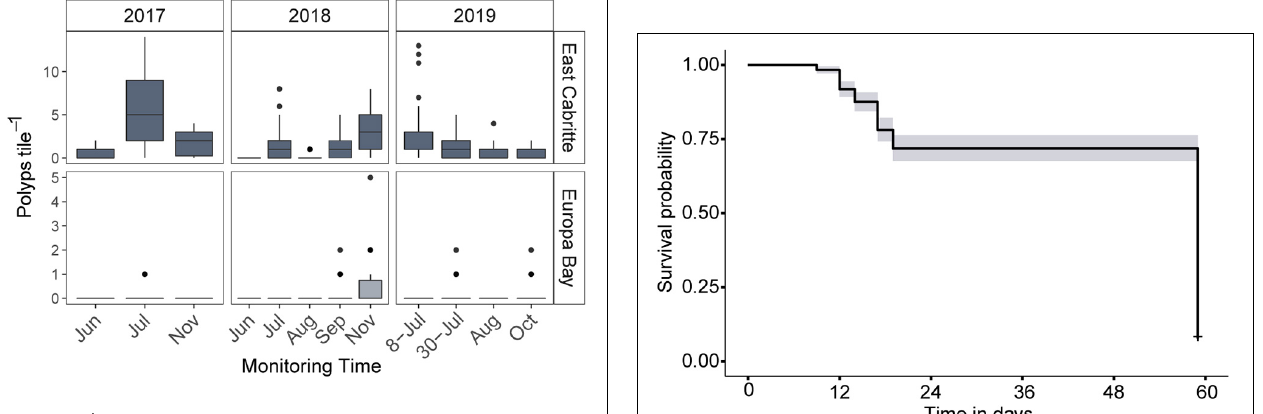
FIGURE 2 | Boxplots comparing the median, 25th and 75th percentiles of polyps tile - 1 among sampling times, and between sites in 2017, 2018, and 2019. Note scales of the y-axes at each site are different, and settlement tiles were monitored different months each year. Recruitment, which was measured within 2 weeks of settlement, was consistently higher at East Cabritte than at Europa Bay each year ( p < 0.001). At East Cabritte, the number of polyps on the tiles decreased in July 2018 ( p < 0.01) and increased in July 8, 2019.